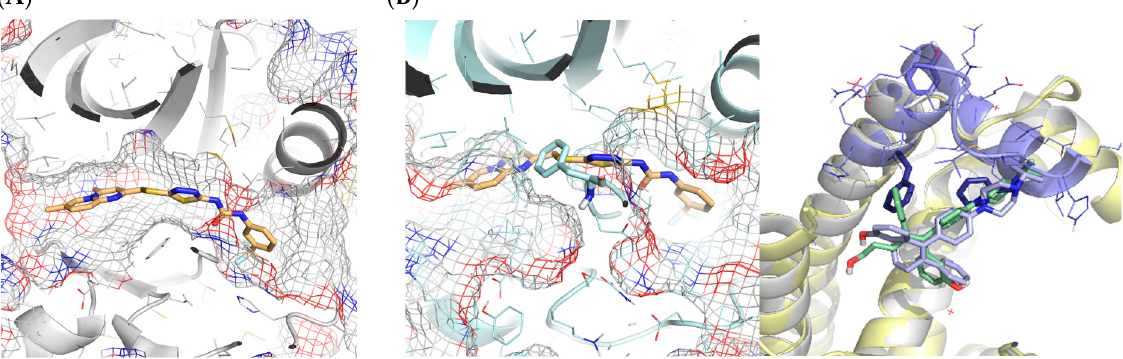
Figure 10. ( A ) Differences in binding site structure organisation between 6pl1 crystal and the selected hiTanimoto receptor by CELPP; the correct ligand pose is represented in beige, ( B ) Differences in site conformations for target 6a6k between receptor hiResHolo in purple, the crystal structure in white and hiTanimoto receptor in yellow. The ligand crystal pose is represented in green and in light purple is the pose obtained using the hiResHolo receptor.